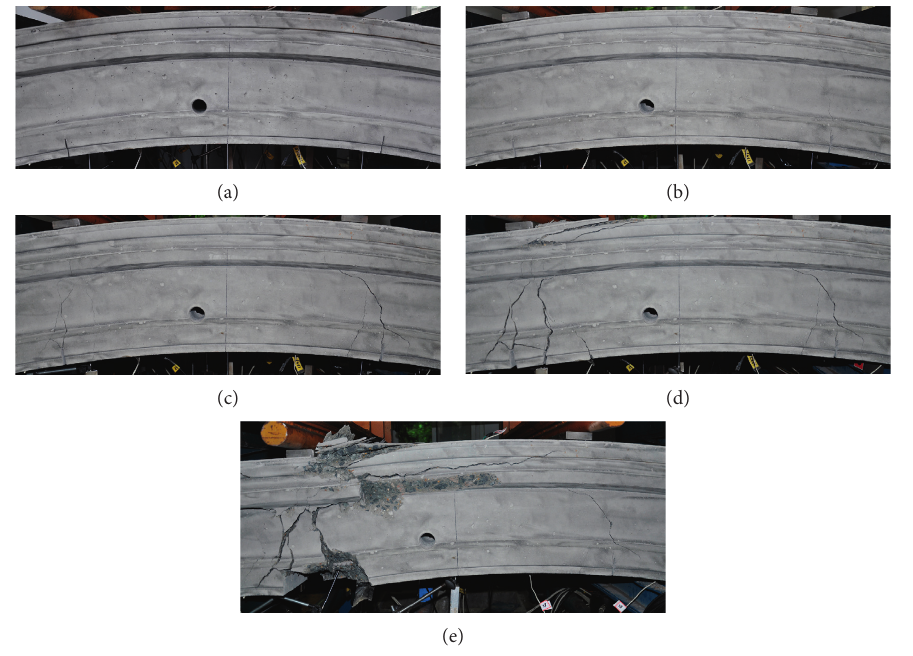
Figure 8: The deformation and failure process of the defective